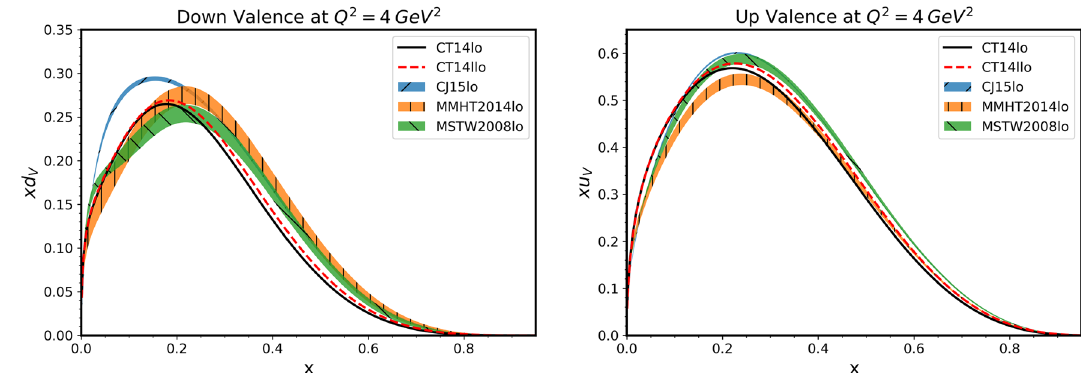
Fig. 12 The h(x) distribution at Q 2 = 4 GeV 2 . Left panel for valence d-quark distribution. Right panel for valence u-quark